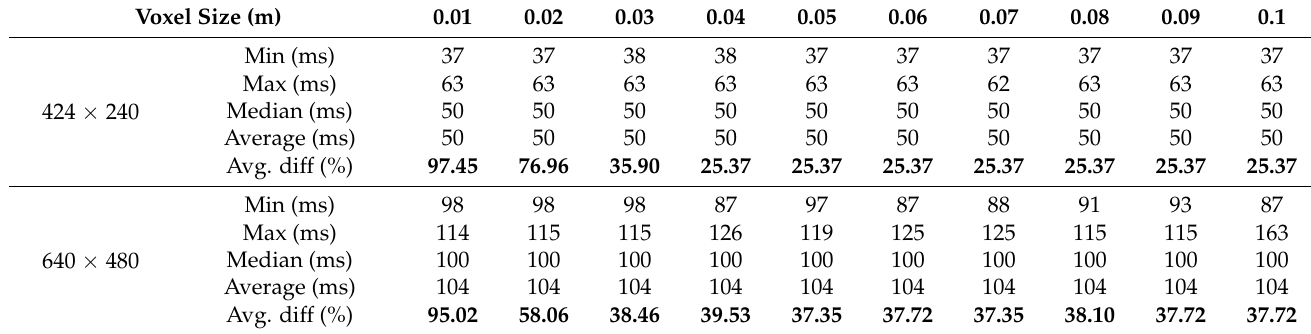
Table 2. Time required to process the whole scene with three cameras for various voxel sizes and camera resolutions using the distributed approach. For each camera resolution, the percentage difference of the average value (Avg. diff) compared to the centralized system is